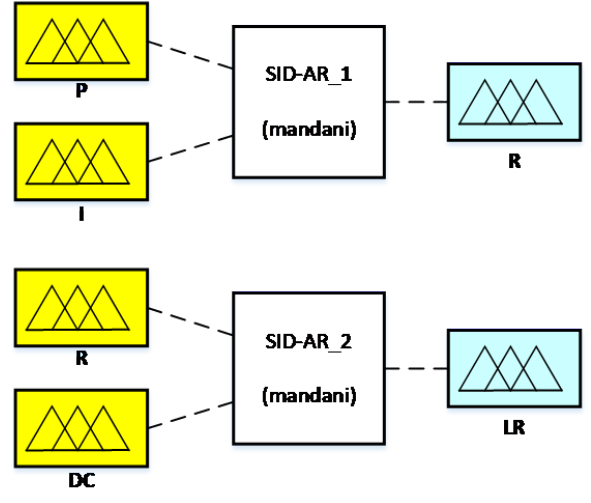
Figure 4: Fuzzy Inference System for level 1 and 2.